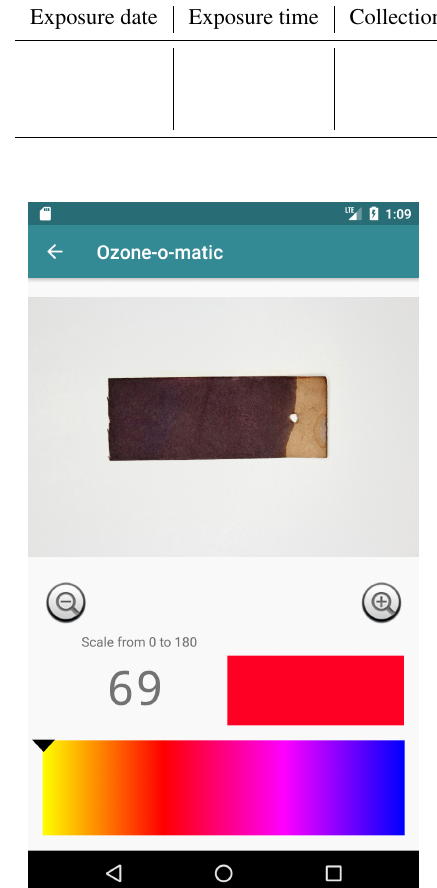
Figure 7. Capture of the output by O3METER (mobile version).